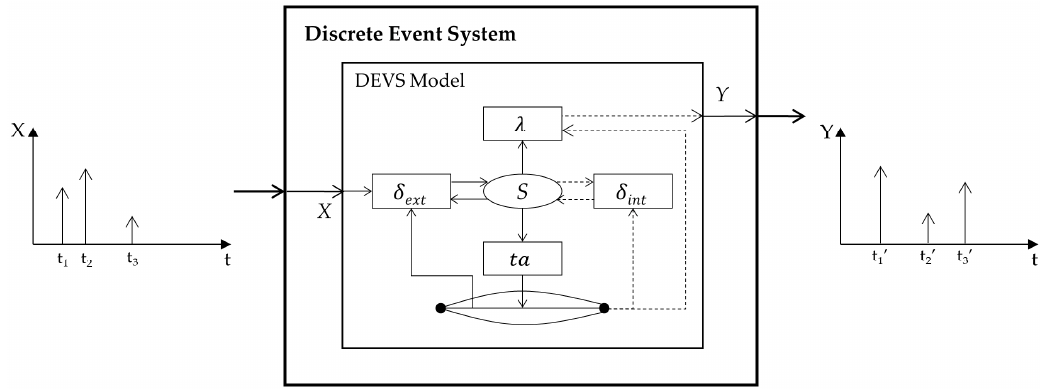
Figure 2. An example of a discrete event system model: Discrete event system specification (DEVS) model.